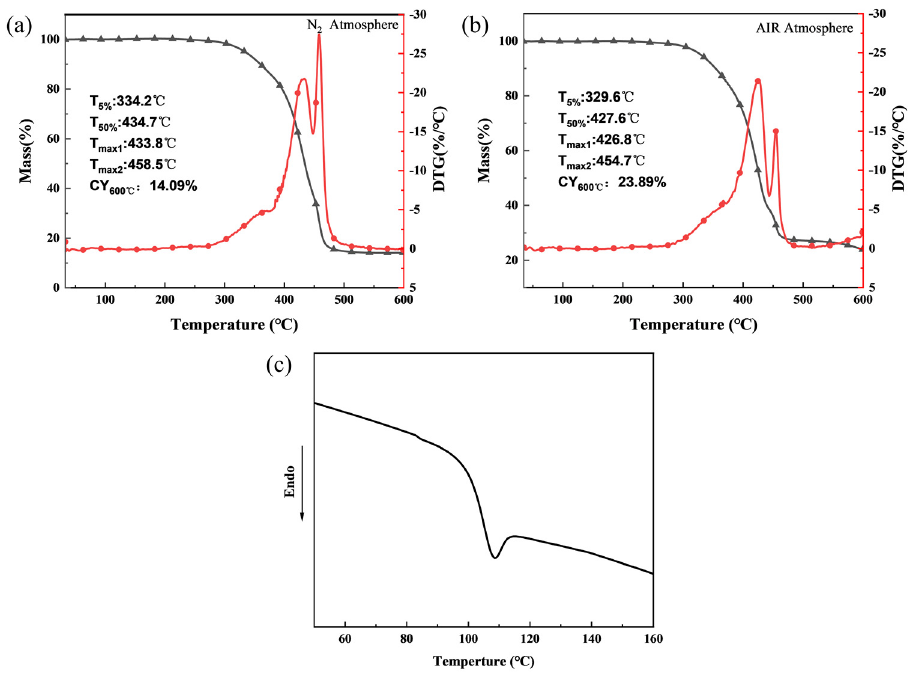
Figure 2. TG and DTG curves of hbDT ( a ) under N 2 atmosphere and ( b ) under air atmosphere, ( c ) DSC curve of hbDT in N 2